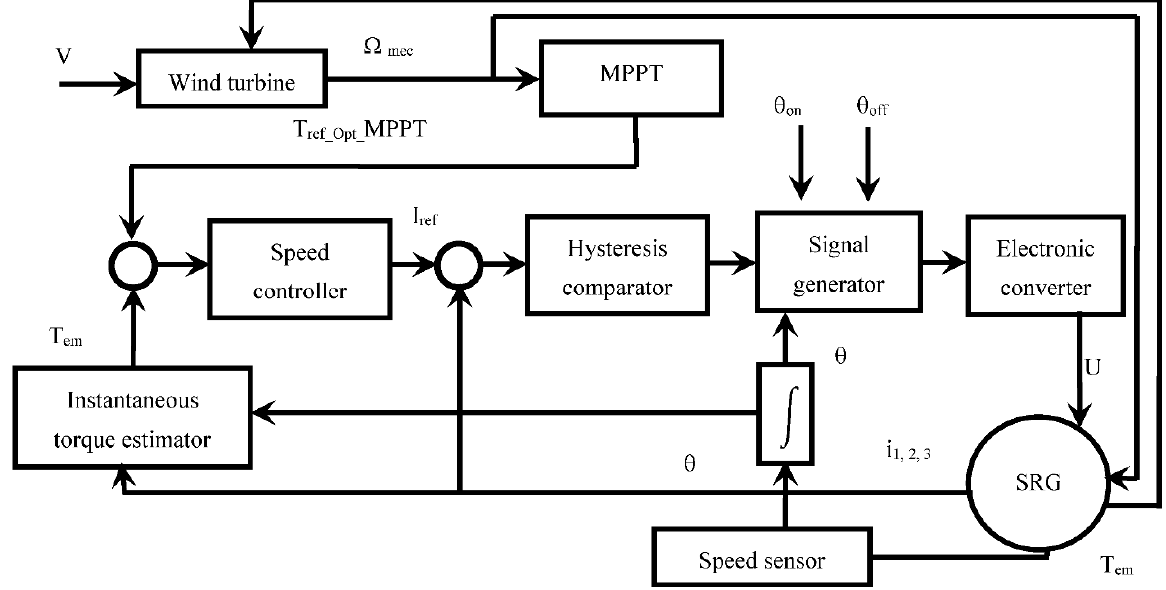
Figure 13. The HCC of the SRG associated with the wind turbine MPPT.